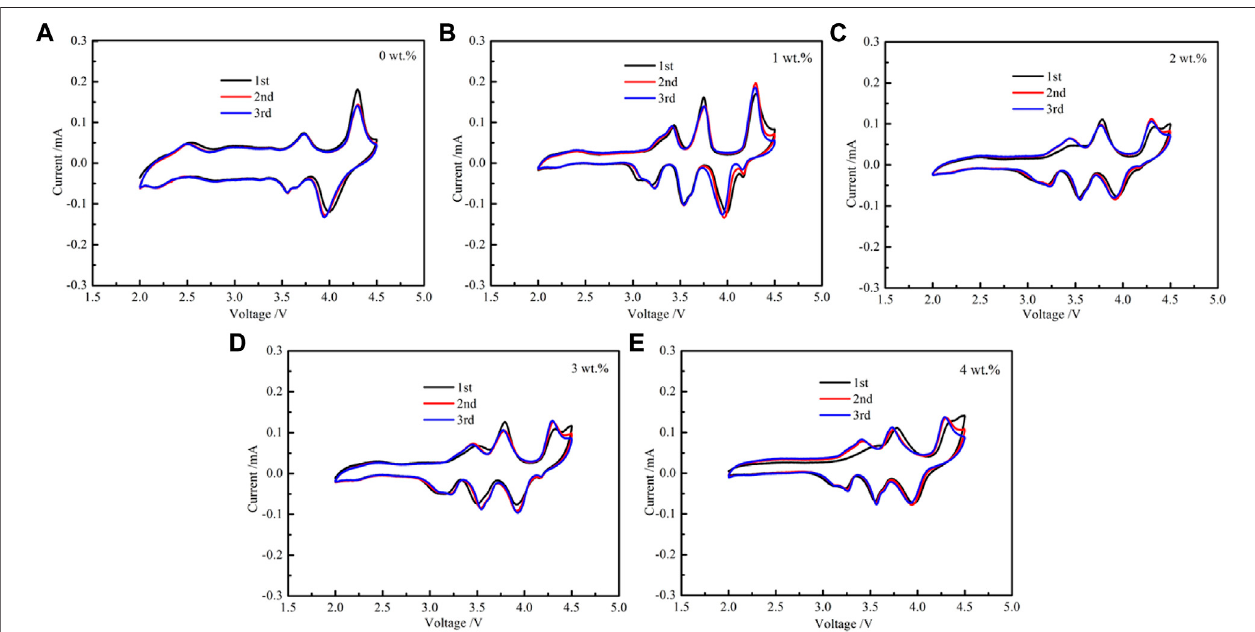
FIGURE 5 | Cyclic voltammograms of NM and MgO-coated samples. (A) NM; (B) 1 wt%; (C) 2 wt%; (D) 3 wt%; (E) 4 wt%.